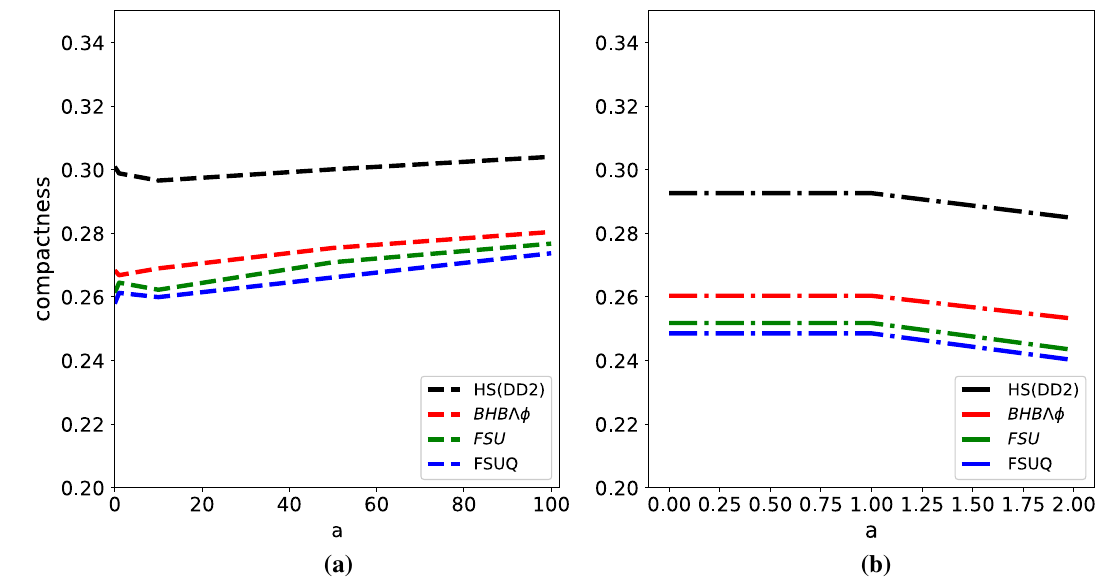
Fig. 4 a Compactness of NS for different EoS using non-perturbative method. b Compactness of NS for different EoS using perturbative method